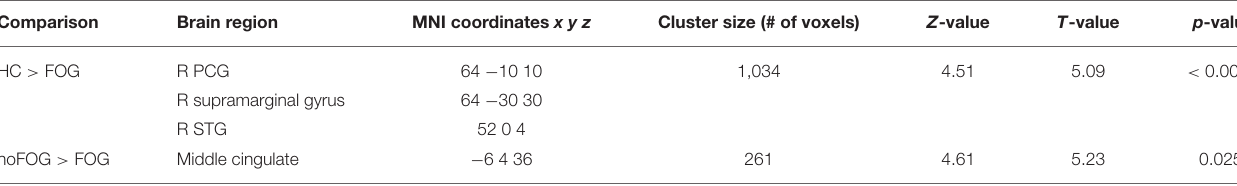
TABLE 2 | Brain regions showing between-group significant differences in FC within the brainstem network.